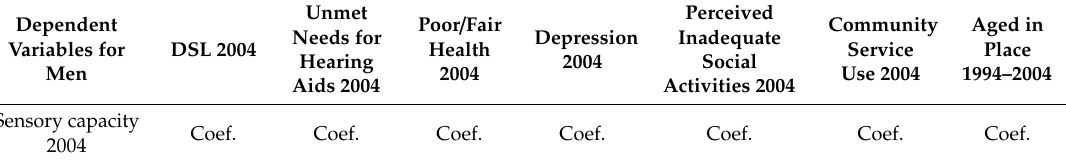
Table 12. Multivariate regression results on DSL incidence and its influences, 2004 men. Dependent Variables